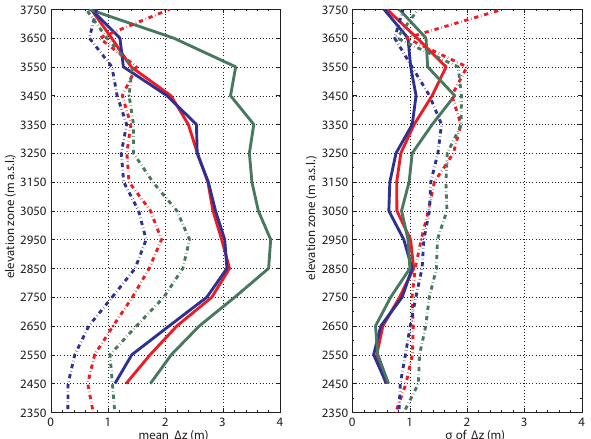
Fig. 5. Elevation distribution of the mean surface elevation change 1z and the standard deviation σ of surface elevation changes ob- tained from the DEM differences. data of the 2002 accumulation season are plotted in blue, data of 2003 in red and data of 2009 in green. Solid lines are the values of glacierized areas. Dotted lines show data of unglacierized